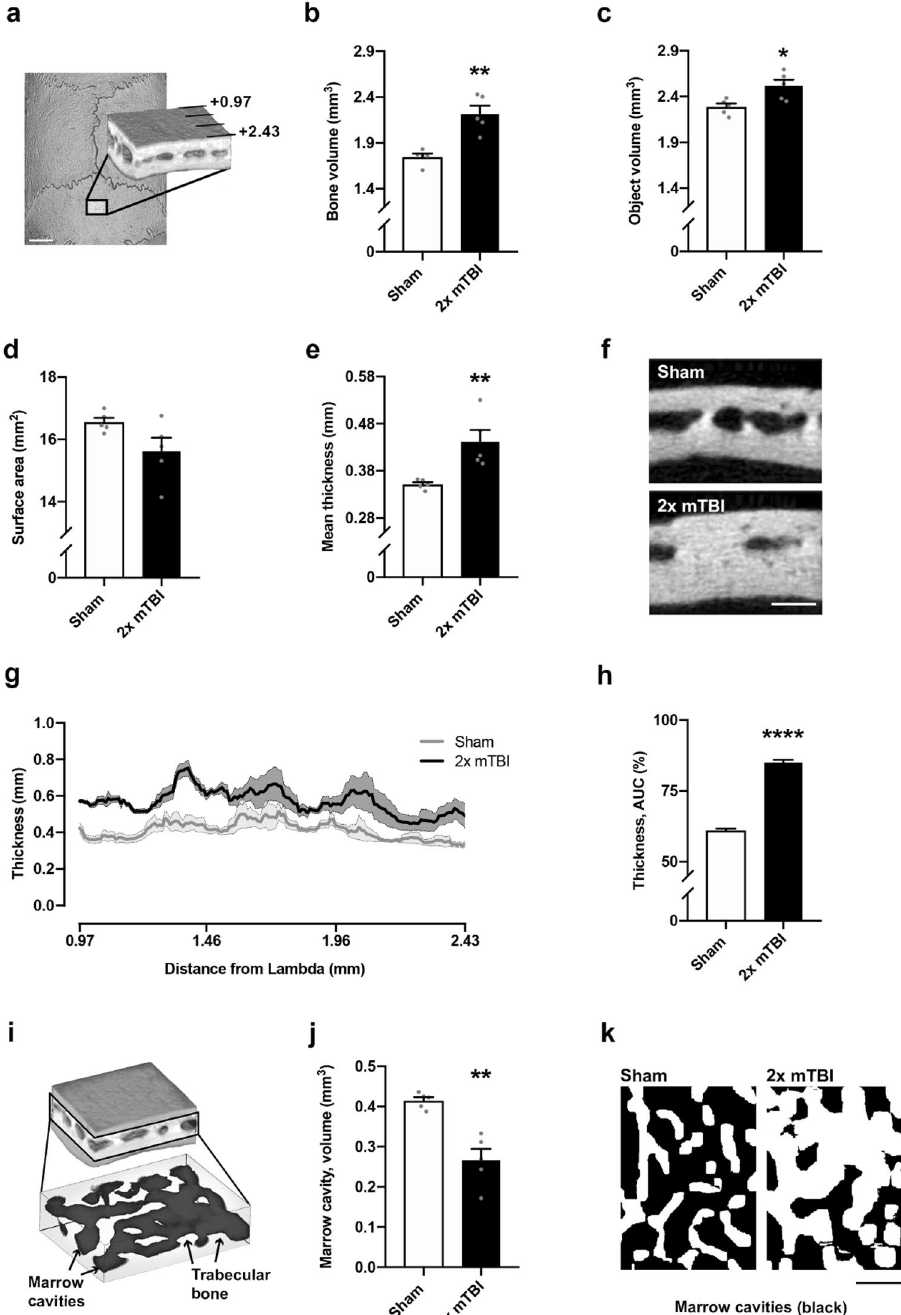
Figure 3. A robust increase in volume and thickness of the interparietal bone was observed at 10 weeks after rmTBI. The interparietal bone region-of-interest (ROI) is depicted in ( a ), mirroring the ROI considered at the 2 week time point (scale bar = 2 mm). Quantification of mineralized bone volume ( b ) revealed a significant increase in the 2× mTBI group compared to sham controls (t-test, **p < 0.01), as well as the object volume (i.e. bone plus marrow cavity space; c ; *p = 0.02). Exterior surface area did not reach statistical significance ( d ). Mean mineralized bone thickness, averaged across 150 adjacent sections, was significantly increased in 2× mTBI mice ( e , post-hoc **p < 0.001), as visualized by representative greyscale microCT images from the ROI z-stack center ( f , scale bar = 500 µm). Mineralized bone thickness was also visualized across the rostrocaudal axis ( g ), with the 2× mTBI group (black line, dark grey error range) across the 150-image span of the 1.47 mm deep interparietal ROI, which was quantified by area under curve analyses ( h , ****p < 0.0001). The volume of marrow cavities (dark grey) were distinguished from trabecular bone (light grey) in the diploë region of the interparietal bone ( i ), revealing a significant decrease in total cavity volume in the 2× mTBI group compared to sham controls ( j , **p < 0.01). Representative superior view, binary projections of the diploë ( k ) illustrates a robust reduction in marrow cavities in 2× mTBI mice compared with sham controls (scale bar = 500 µm). N = 5/group; unpaired student’s